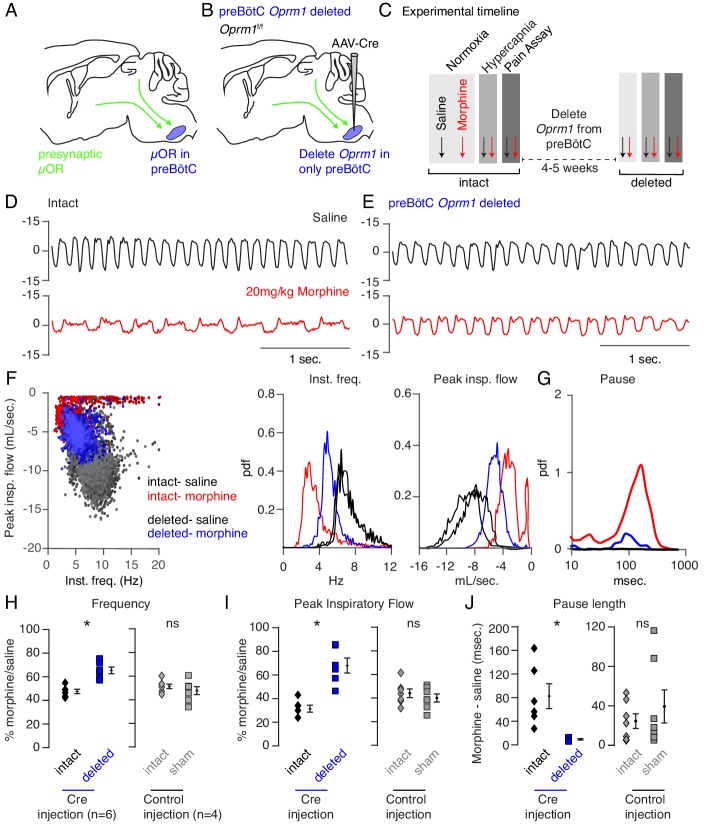
Necessity of preBötC ventrolateral brainstem in opioid-induced respiratory depression.(A) Schematic of a sagittal section through the adult mouse brain. The µ-Opioid receptor (Oprm1) is expressed by a subset of preBötC neurons and is also expressed on presynaptic terminals of some neurons projecting to the preBötC. This confounds the effects observed after localized preBötC injection of opioid or naloxone to investigate its role in OIRD. (B) To overcome this, we eliminate Oprm1 only from the preBötC, and not the presynaptic inputs, to define the role of preBötC neurons in OIRD. (C) Experimental time-course. Breathing is measured 15 min after IP injection of saline or 20 mg/kg morphine in both normoxia and hypercapnia. Then Oprm1f/f animals are injected with a constitutive-Cre AAV into the preBötC bilaterally. After several weeks breathing is assayed again as above. In this way, each animal’s breathing before viral injection can serve as its own control breathing. Response to pain is also measured with a tail-flick assay before and after viral injection to ensure that analgesic response is unaffected. (D–E) Representative examples of the breathing airflow (mL/sec.) in hypercapnia after saline (black) or morphine (red) before (D) and after (E) Cre-virus injection. (F) Scatter plot of instantaneous respiratory frequency vs. airflow (ml/sec), as well as probability density function plots of both parameters for a representative animal during hypercapnia after saline (black) or morphine (red, blue) IP injection, before (red) and after (blue) Cre-injection. (G) Probability density function plot of pause length (msec.) for a representative animal during hypercapnia after IP morphine before (red) and after (blue) Cre-injection, log scale. Prevalence of long duration pauses is greatly reduced. (H–J) Ratio of average breathing parameters after IP injection of morphine-to-saline. Respiratory rate (H) p-value=0.003, Cohen’s d = 3.0), peak inspiratory airflow (I) p-value=0.0005, Cohen’s d = 3.01), and pause length (J) p-value=0.04, Cohen’s d = 2.0) for 6 Oprm1f/f animals with Cre-virus injected into the preBötC or 7 control animals with reporter-virus injected into the preBötC. All sham p-values were not significant (>0.09) and Cohen’s D < 0.6. For each experiment ‘intact’ values are before viral injection, with ‘deleted’ and ‘sham’ values representing post viral injection conditions in experimental and control animals, respectively. Diamond and square, single animal average. Mixed repeated two-way ANOVA comparing Cre vs. Sham injected was statistically significant for respiratory rate (F(1,11)=5.5, p-value=0.04) and pause (F(1,11)=6.2, p-value=0.03), but not for peak inspiratory airflow (F(1,11)=2.1, p-value=0.17) Black diamond, average of all animals. Error bar, standard error of mean (SEM). * indicates p-value<0.05. ns indicates p-value>0.05.Figure 2—source data 1.Average frequency, peak flow and pause duration after intraperitoneal saline or morphine in hypercapnia at baseline or after Oprm1 deletion from the preBötC.Figure 2—source data 2.Average frequency, peak flow and pause duration after intraperitoneal saline or morphine in hypercapnia at baseline or after sham viral injection into the preBötC.